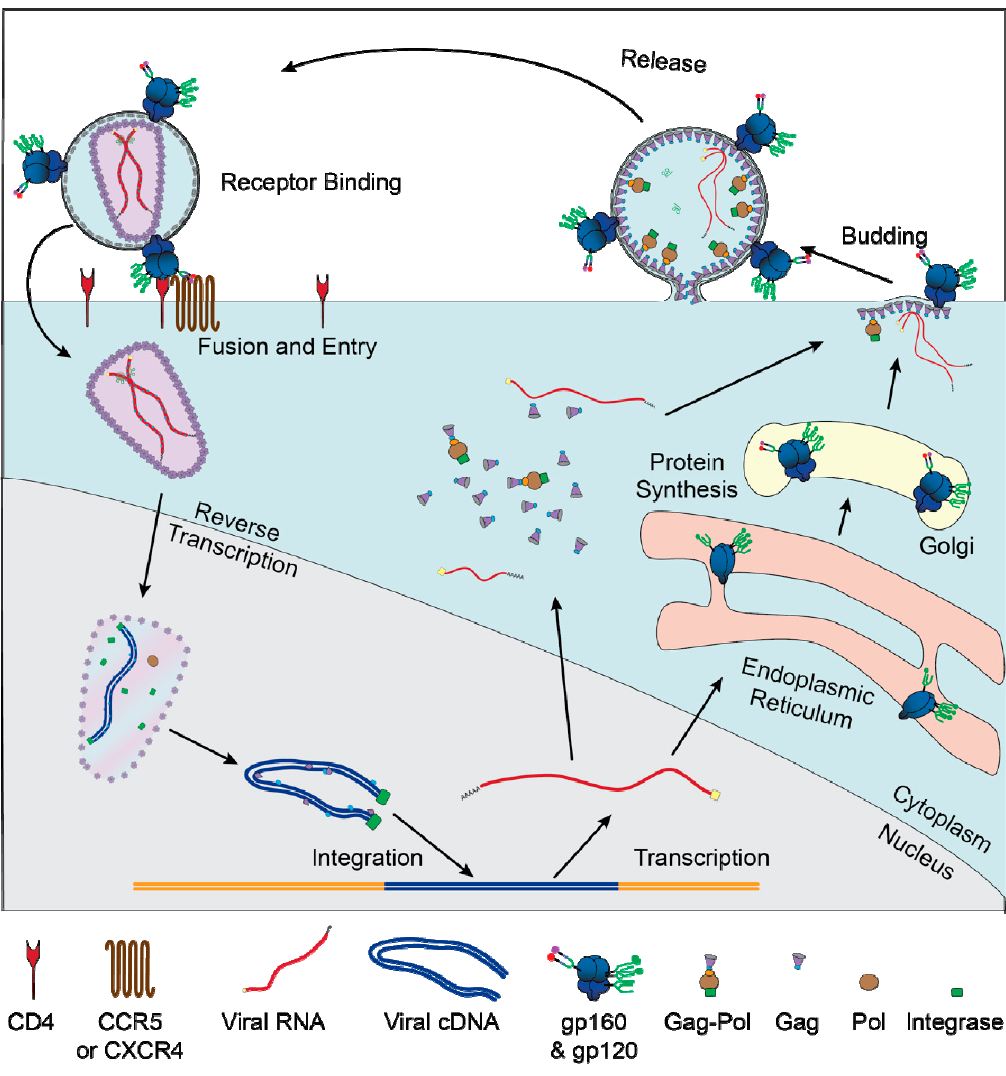
Figure 1. Replication cycle of HIV: graphical depiction of the major events of the HIV replication cycle. Viral entry is mediated by binding of Env to CD4 and a co-receptor (CXCR4 or CCR5). After the viral membrane fuses with the plasma membrane the capsid and RNA genome are transported into the nucleus. The viral genome is reversed transcribed by Pol and integrates into the host genome. The host RNA polymerase transcribes RNA copies of the genome, which are exported in an unspliced form to produce Gag and Gag–Pol or various spliced forms to produce the other viral proteins. Unspliced RNA genomes are also packaged into newly formed virions. Most viral protein translation occurs in the cytoplasm, but Env gp160 is translated into the lumen of the rough ER and transported through the secretory pathway, where it is glycosylated and cleaved by furin into gp120 and gp41. After entry to the cell, the capsid and viral RNA genome are imported into the nucleus, where the genome is reverse transcribed to produce a double-stranded cDNA copy and the capsid disassembles [9]. Whereas most retroviruses wait for the nuclear membrane to be dissolved during mitosis, the